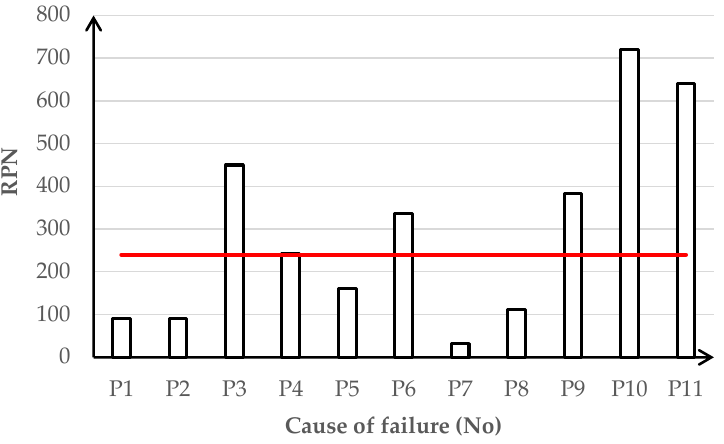
Figure 9. RPN of the structural failures caused by human error (own study)